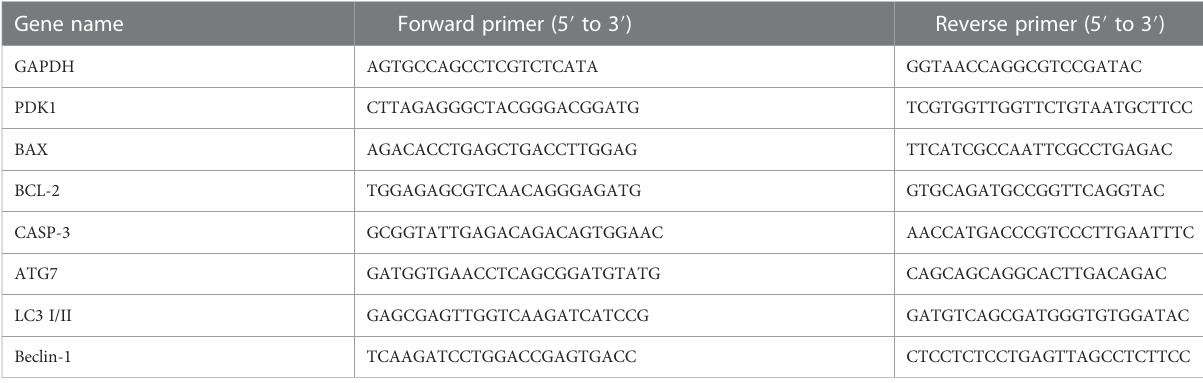
TABLE 1 Primer sequences used in this